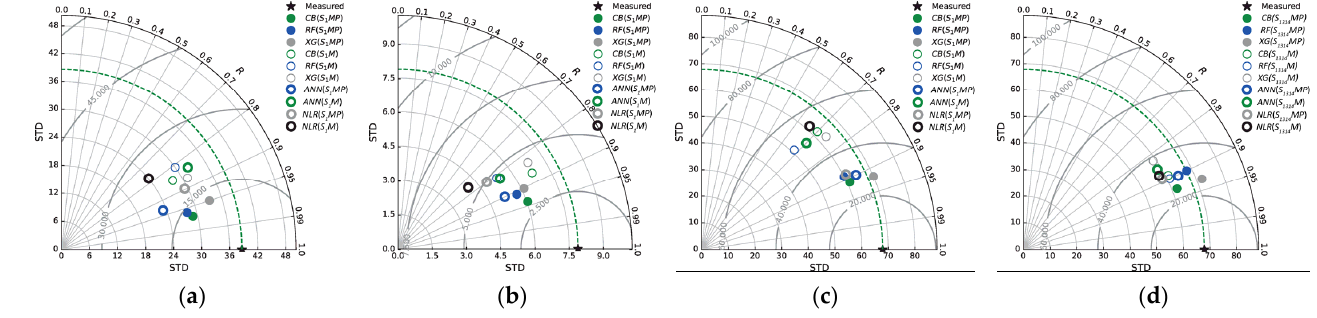
Figure 4. Taylor diagrams for the testing phase: ( a ) Durucasu Station, ( b ) Sutluce Station, ( c , d ) Kale Station.